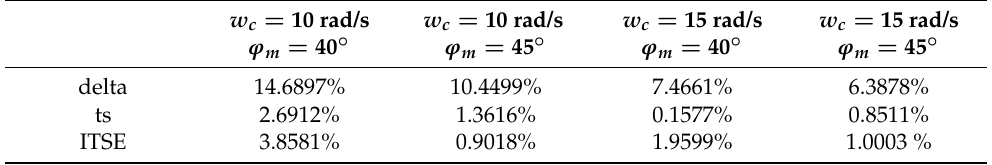
Table 2. Performance of FO-impedance controller compared with that of IO-impedance controller under different gain crossover w c and phase margin ϕ m